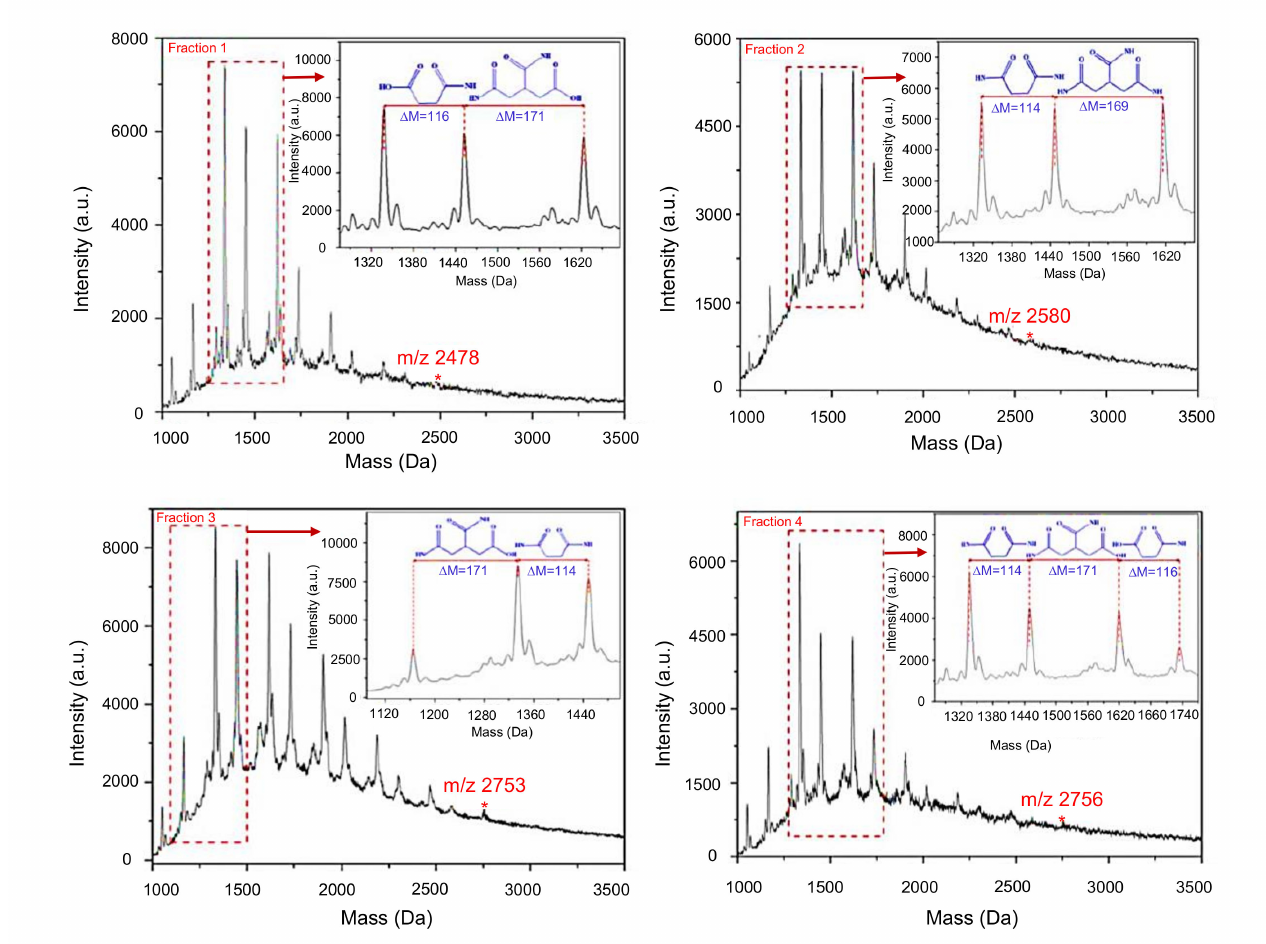
Figure 6. Graphical representation of different MS spectra from MALDI-TOF MS analysis of various fractions of CDs. Reproduced from [166], with permission from Wiley, 2014. a.u.: arbitrary